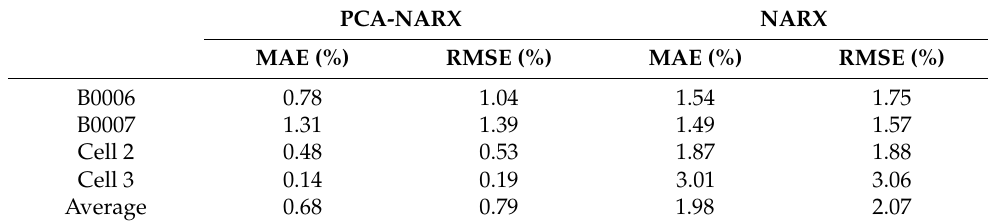
Table 2. Summary of MAE and RMSE before and after PCA.